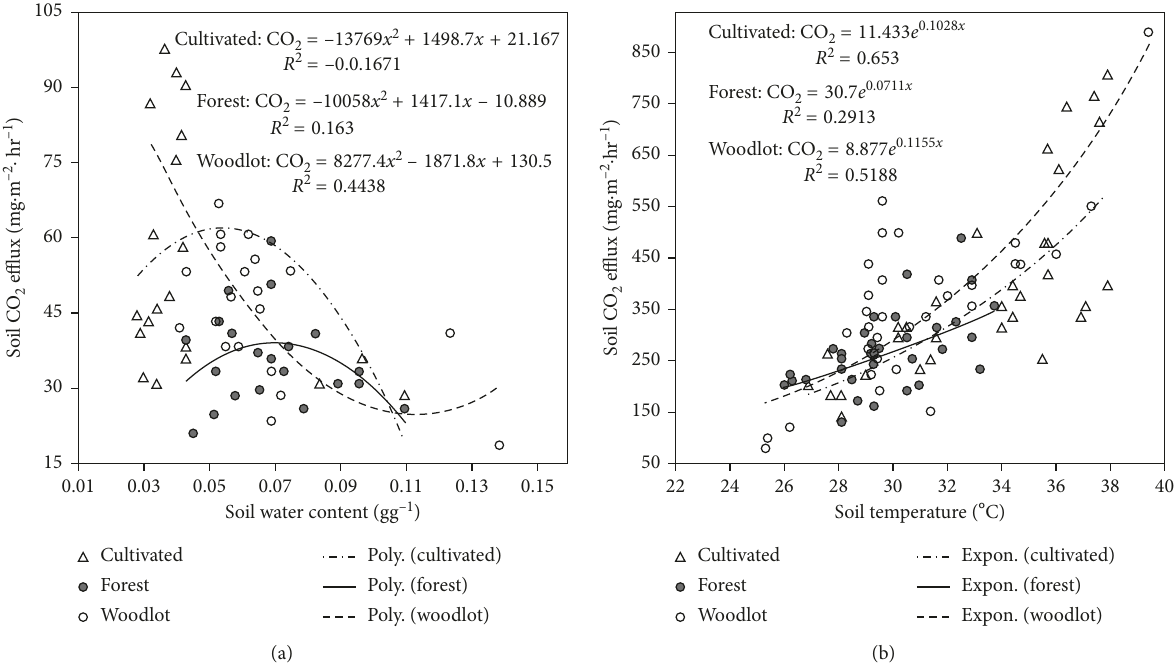
Figure 6 : Relationship between soil water content and soil CO Coastal Savanna agroecological zone of